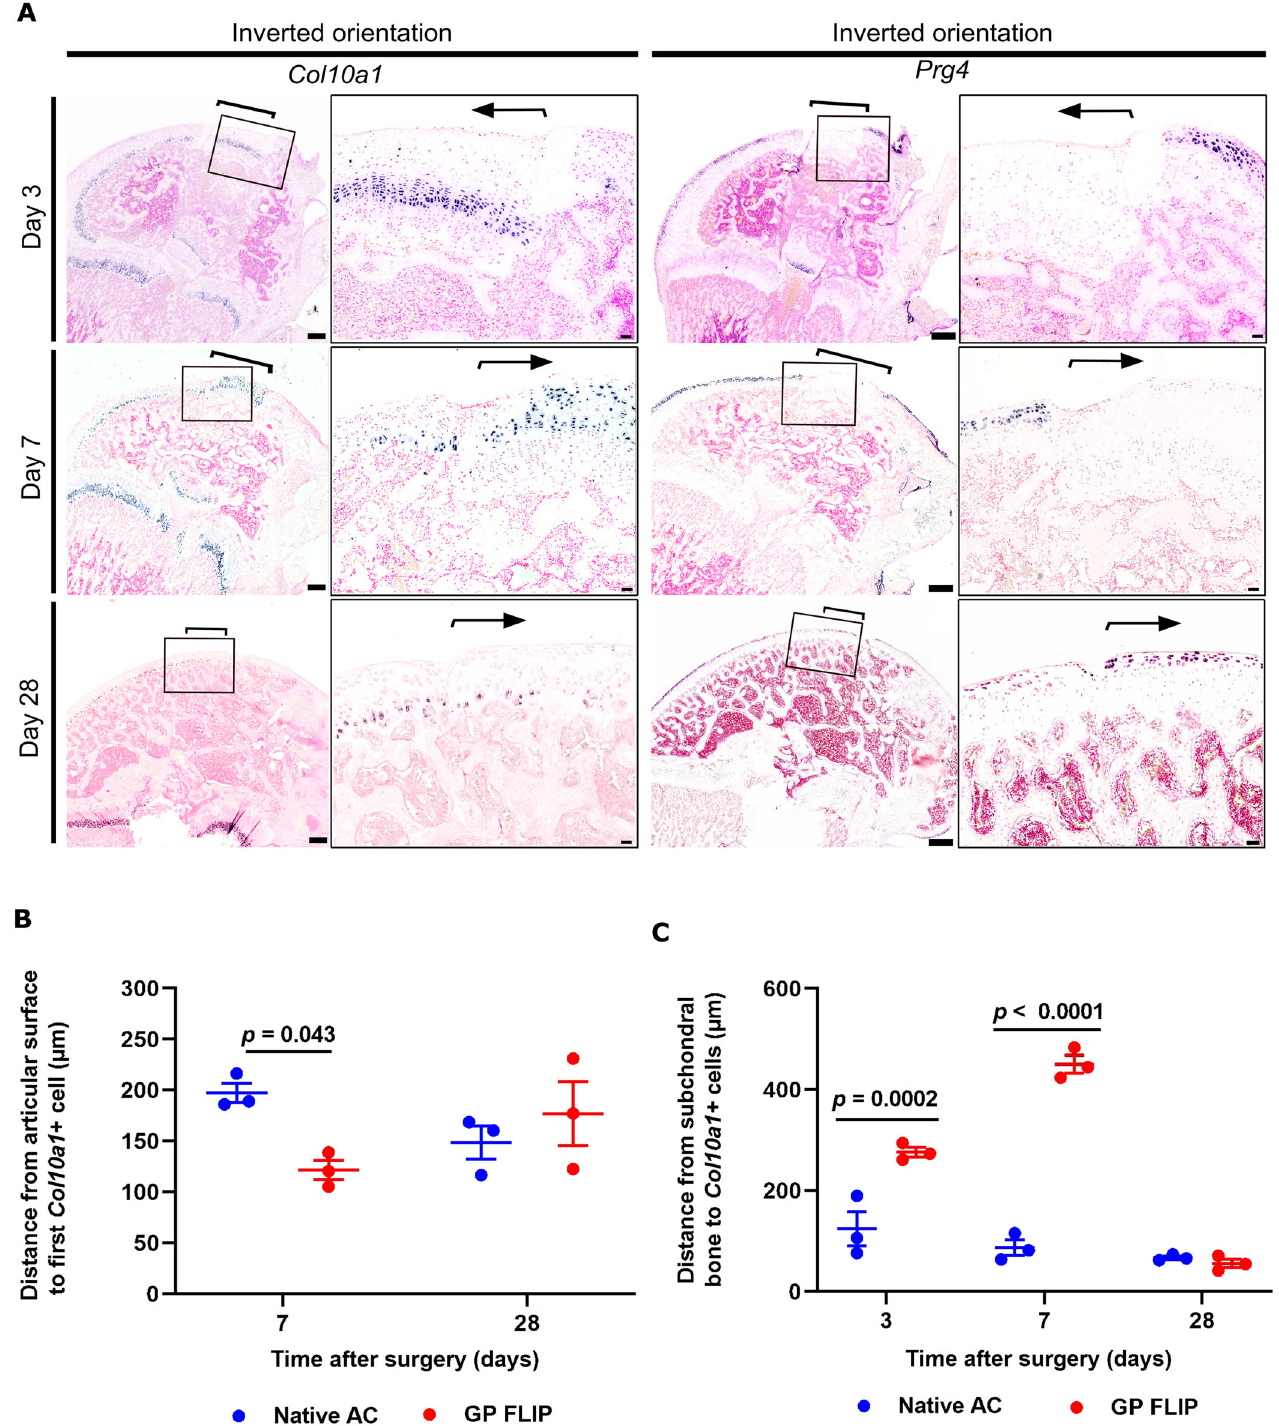
Fig. 4 Localization of Col10a1 and Prg4 expression in transplants inserted in inverted orientation. Osteochondral allografts were harvested from distal femurs of inbred GFP-expressing rats and transplanted to matching sites of wildtype (GFP-negative) littermates in inverted orientation and localized by GFP immunohistochemistry. A Hypertrophic and super fi cial zone chondrocyte differentiation was assessed by Col10a1 and Prg4 in situ hybridization (purple coloration) on consecutive distal femoral sections of recipient rats at postoperative day 3, 7, and 28. Brackets and arrows delineate the location of the transplanted osteochondral allografts. B Distance from articular cartilage surface to fi rst Col10a1-positive cells as well as ( C ) distance from subchondral bone to Col10a1-positive cells were assessed in growth plate transplanted to the articular surface (GP fl ip) and recipients ’ articular cartilage (native AC) ( n = 3 per timepoint; B : 10 – 12 measurements per sample; C : 30 measurements per sample; B , C Two-way ANOVA followed by Tukey ’ s test). Scale bar: 500 μ m and 50 μ m in low- and high-power images, respectively. Bars represent average ± SEM. Each datapoint represents an